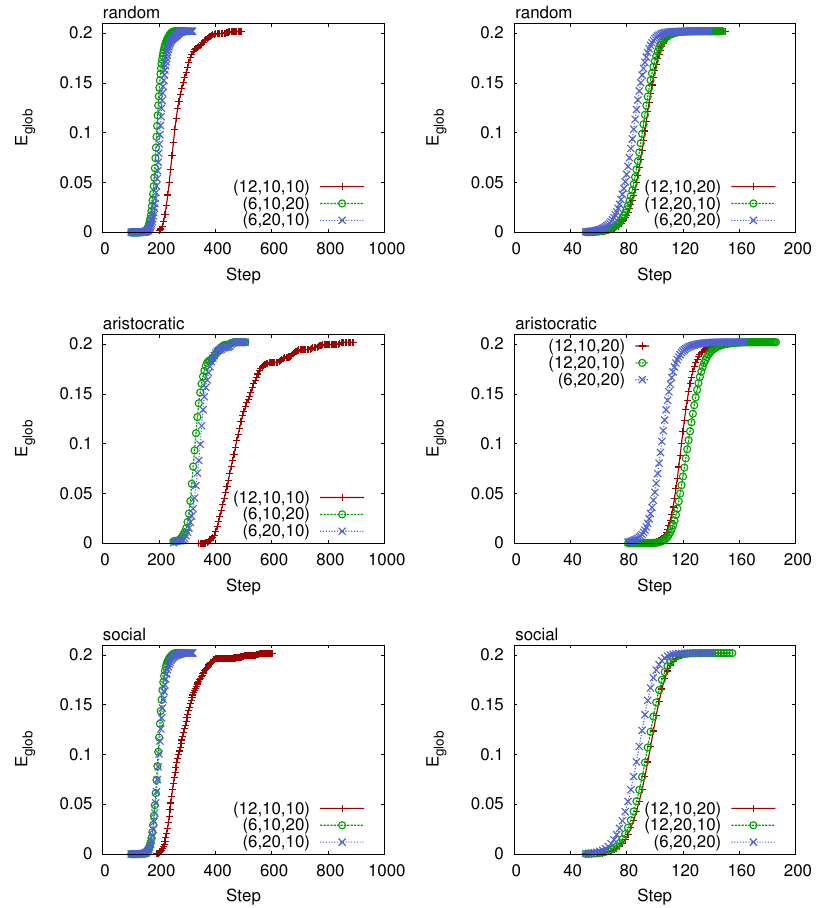
Figure 16. Accelerated analysis with mermaids, random, aristocratic, and social rules, preferential model, in the VirtualTourist social network with cost equal to C s = 1200 ( left panels ) and C s = 2400 ( right panels ). We clearly see that the configurations with higher attractiveness reach faster the target efficiency, regardless of the users’ growing